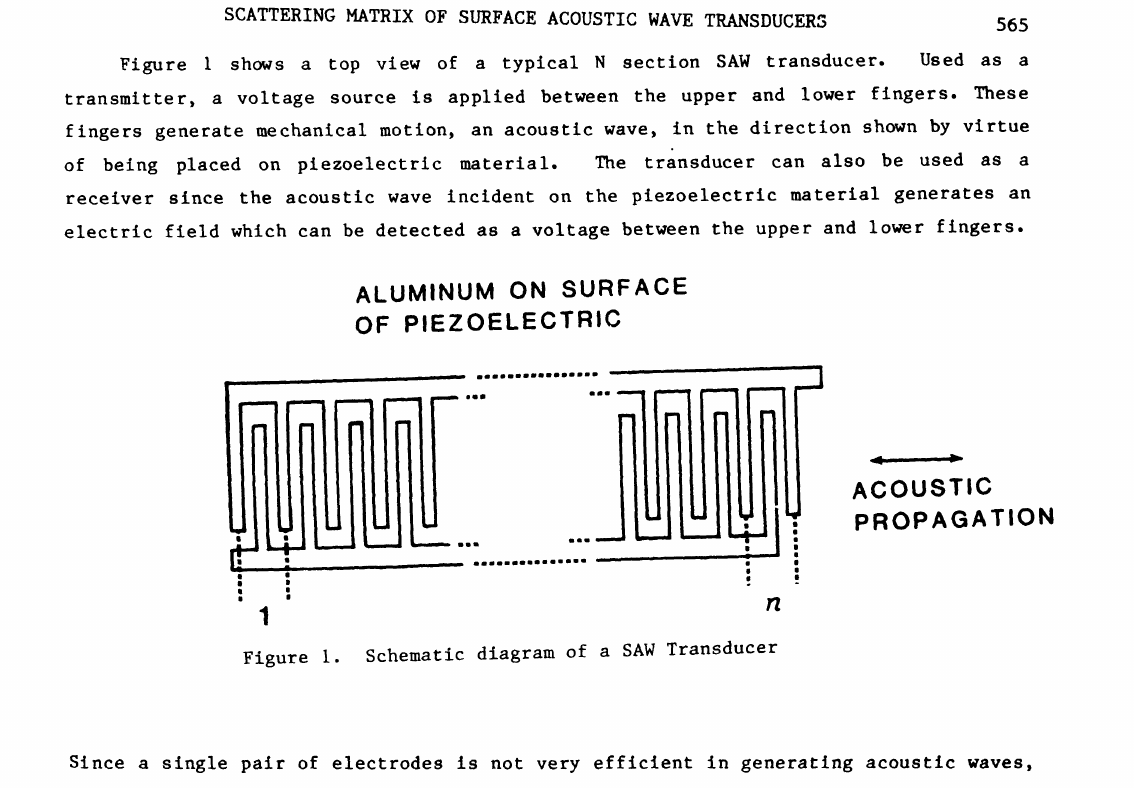
Figure shows a top view of a typical N section SAW transducer. Used as a transmitter, a voltage source is applied between the upper and lower fingers. These fingers generate mechanical motion, an acoustic wave, in the direction shown by virtue transducer can also be used as a of being placed on piezoelectric material. The receiver since the acoustic wave incident on the piezoelectric material generates an electric field which can be detected as a voltage between the upper and lower fingers.